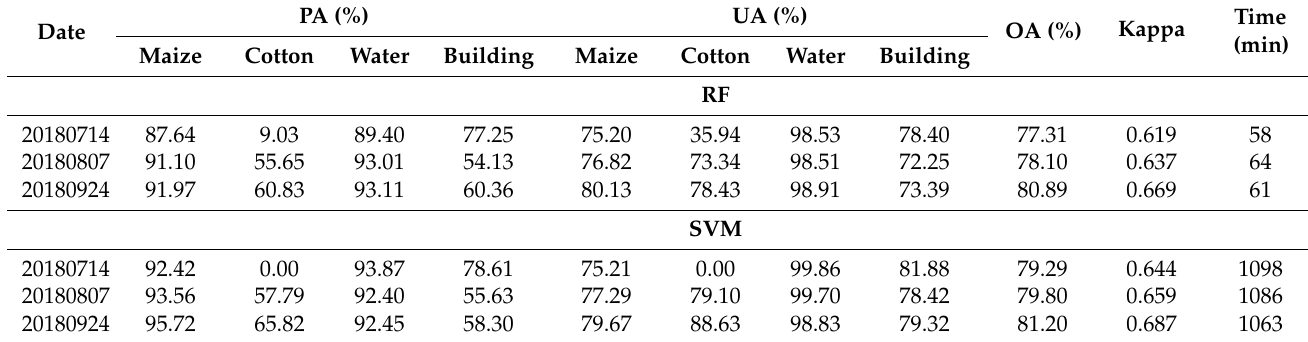
Table 4. Accuracies and Kappa coefficients of the classification of four land-cover types using six features and two algorithms. (PA: producer accuracy, UA: user accuracy, OA: overall accuracy, Kappa: Kappa coefficient, Time: running time for classification).